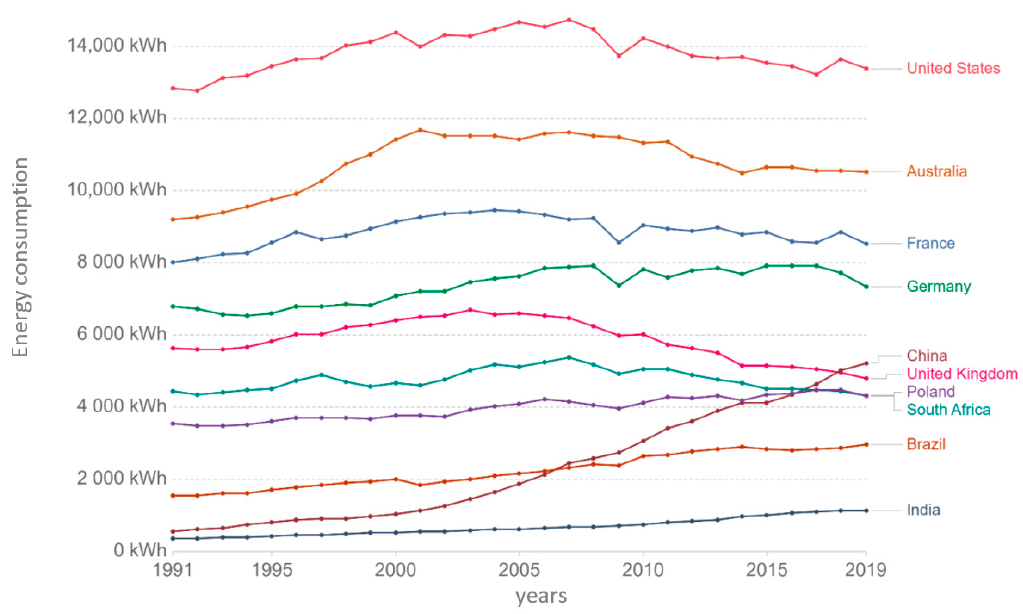
Figure 1. Primary energy consumption in terawatt hours (TWh)—world. Source: [1].